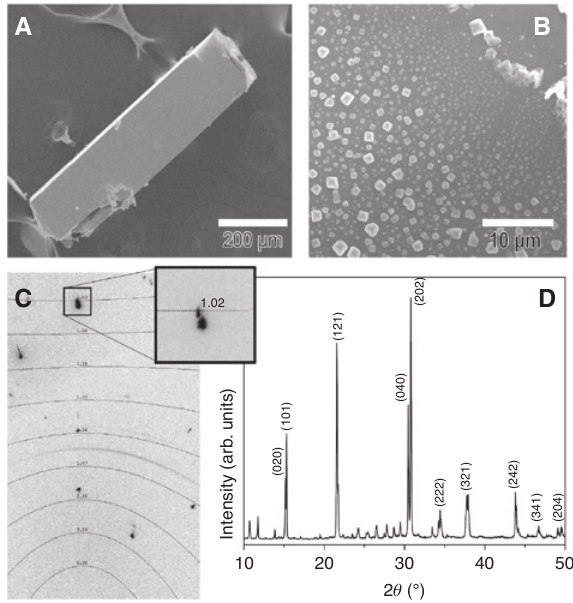
Figure 1: Morphological and structural characterization of the